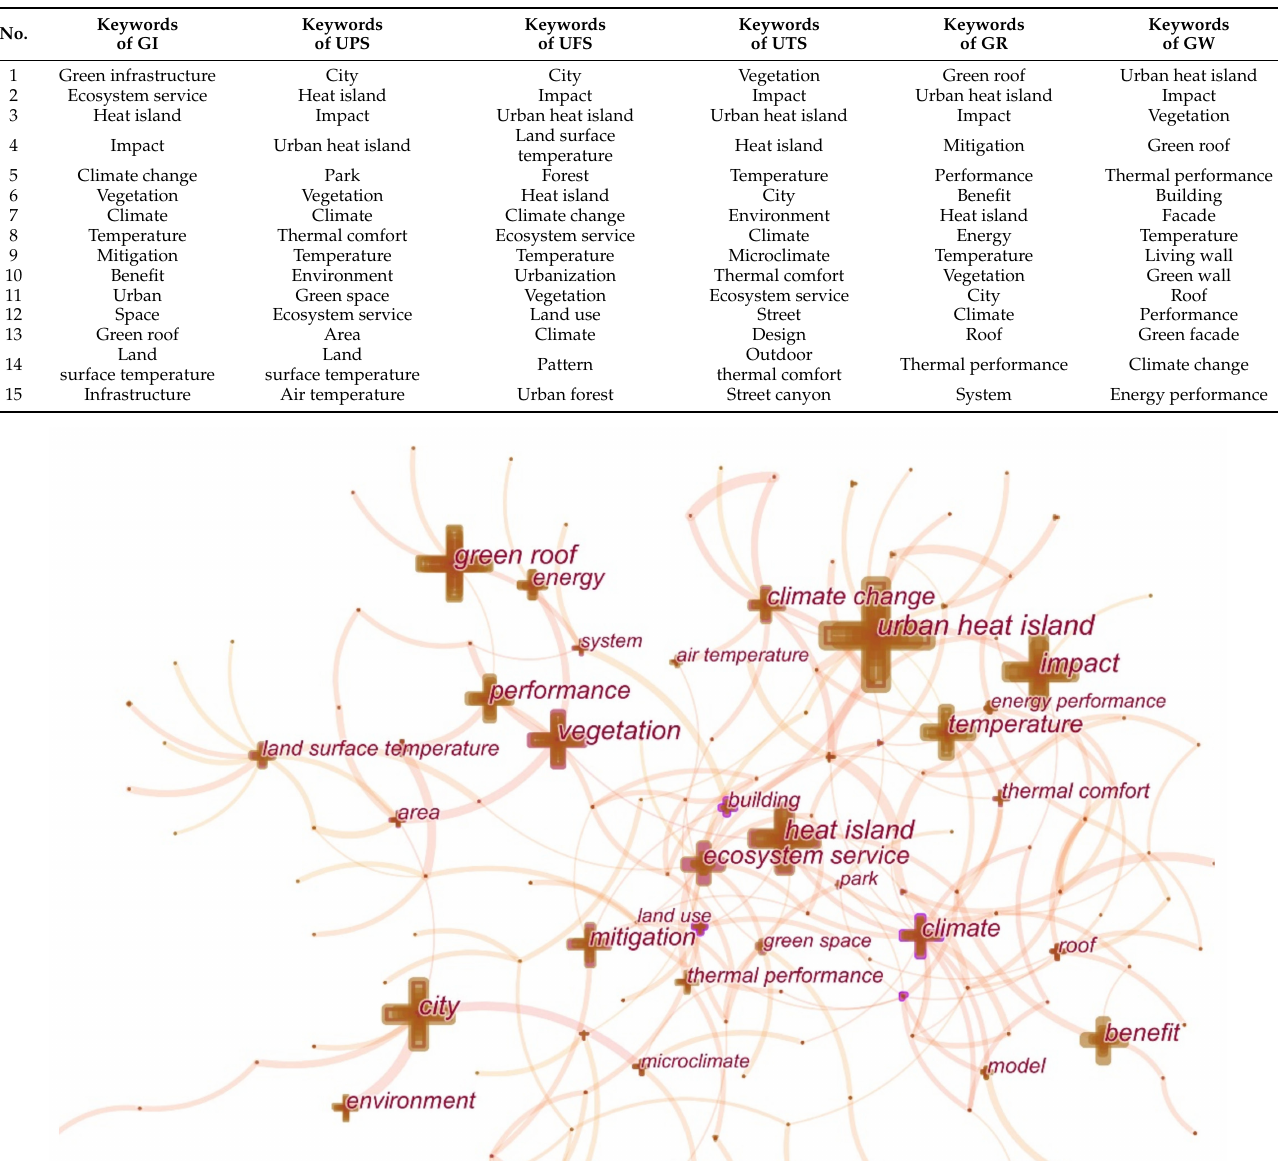
Table 1. Top 15 most frequently used keywords during 1990–2021 for different GI types.